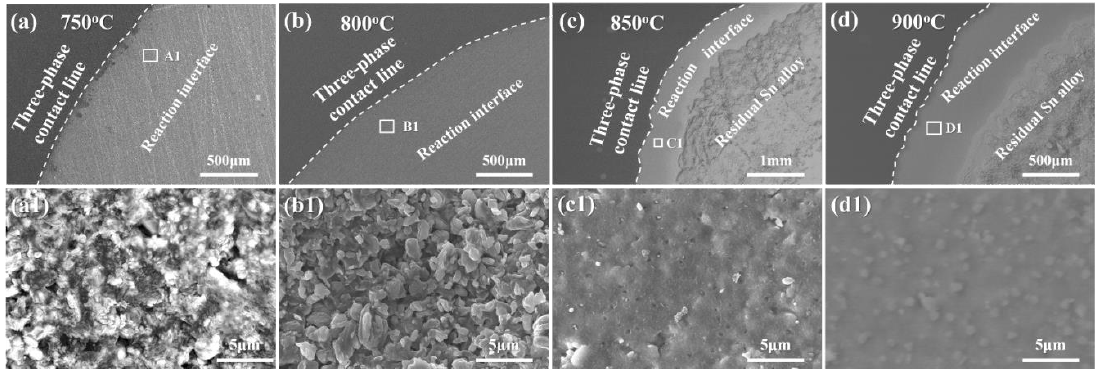
Figure 6. Surface morphologies at the wetting three-phase contact line between Sn-3V alloy and porous graphite after isothermal wetting at ( a ) 750 °C, ( b ) 800 °C, ( c ) 850 °C and ( d ) 900 °C; ( a1 ), ( b1 ), ( c1 ), and ( d1 ) were obtained at locations marked as rectangles A1 in ( a ), B1 marked ( b ), C1 marked in ( c ) and D1 marked in ( d ), respectively.